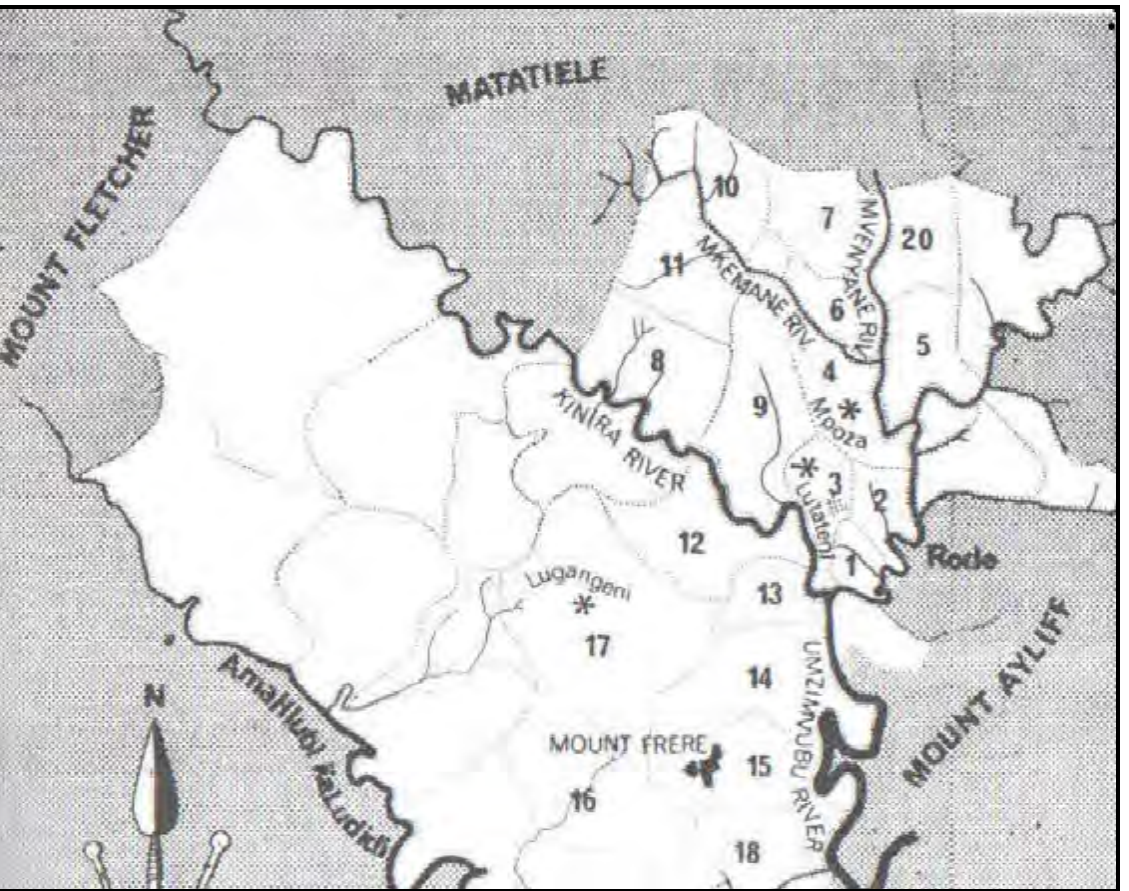
Figure 1: Map of Eastern Cape locating the